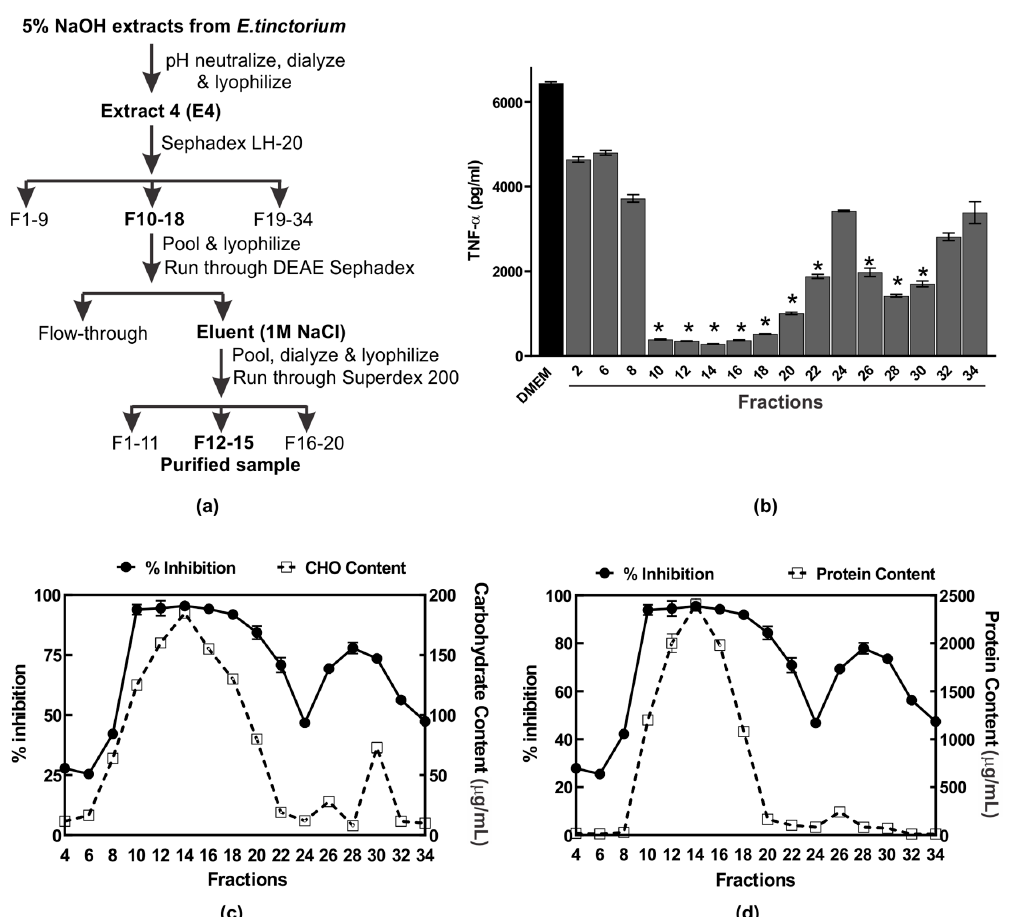
Figure 2. Purification of the anti-inflammatory polysaccharide from Echinodontium tinctorium (AIPetinc). ( a ) Summary of the purification scheme used; ( b ) Profile of anti-inflammatory activity of the NaOH extract after elution from Sephadex™ LH-20 column. The assays were performed in triplicate and the data shown is a representative from three biological replicates ( n = 3). Error bars represent standard deviation. One-way ANOVA was performed as described in Materials and Methods. * denotes p < 0.05 as compared to DMEM using Sidak’s multiple comparison test. Fractions which contained anti-inflammatory activity (expressed as % inhibition) were also assessed for